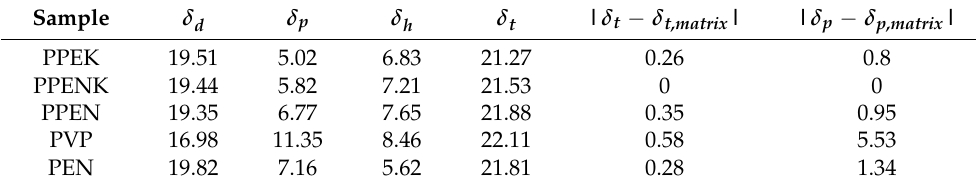
Table 1. Solubility parameter values of the PPENK matrix resin and sizing agents a .